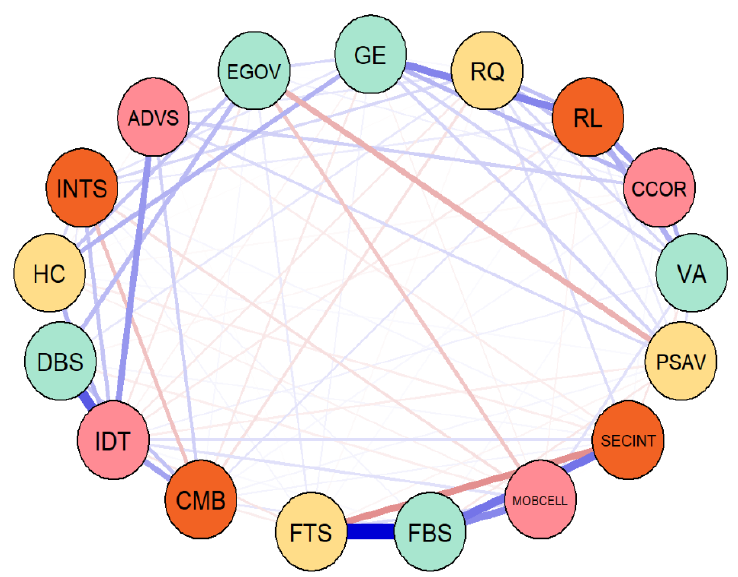
Figure 5. Results of the Gaussian graphical model (GGM). Source: Authors’ research in RStudio 4.2.2.